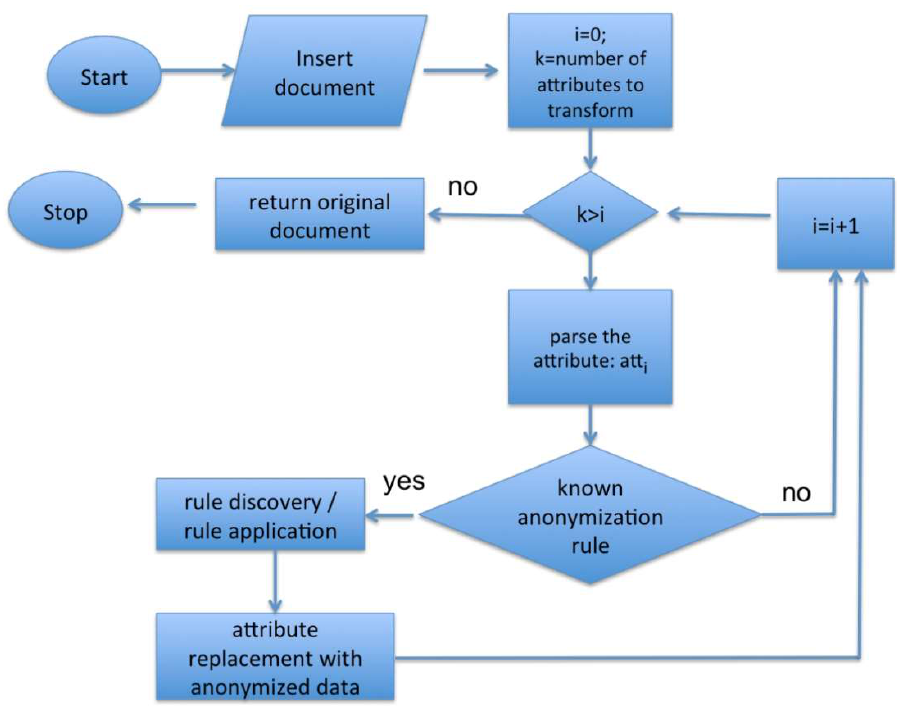
Figure 2. Flow chart of an anonymization algorithm.